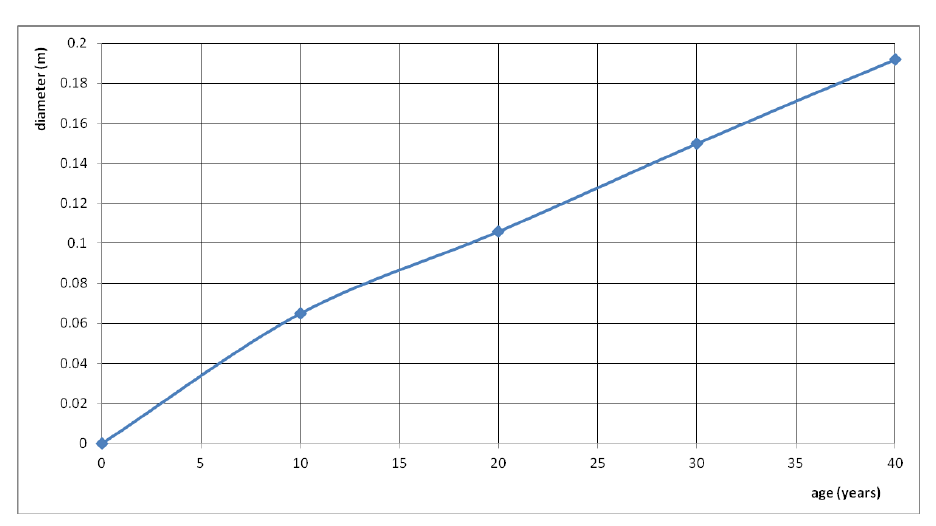
Figure 5. Variability in the diameter values depending on age. Own study based on the authors' data and